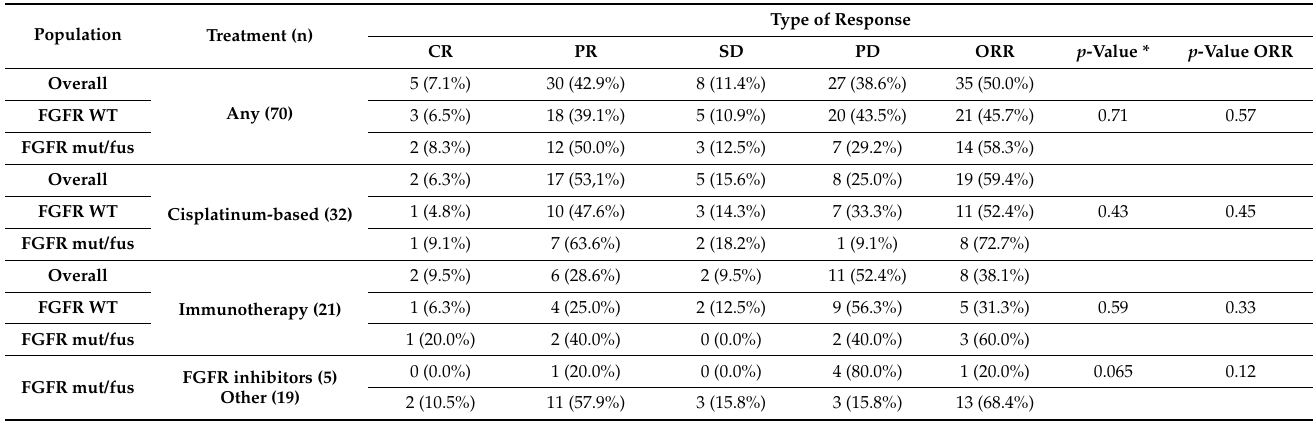
Table 3. Treatment response to first-line therapy according to FGFR status and specific therapy according to the RECIST criteria